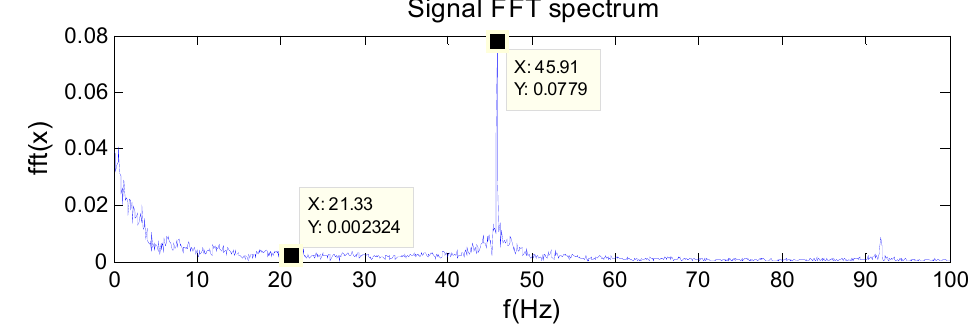
Figure 4. The FFT spectrum of the wheel hub bearing signal.